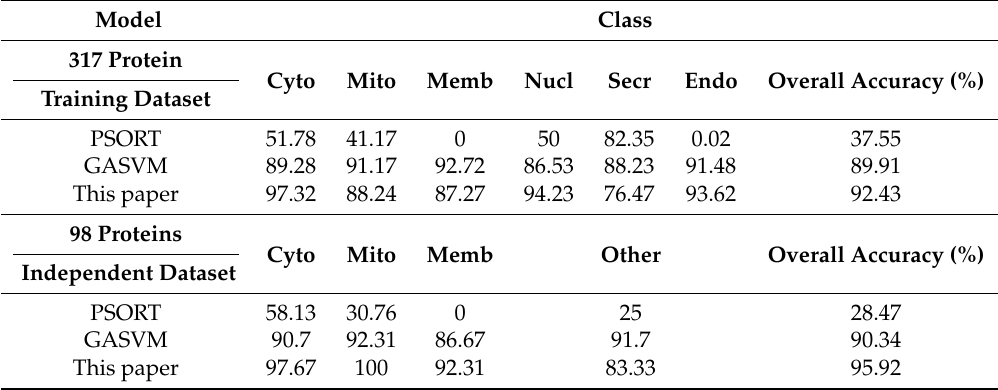
Table 15. Prediction results with different models on the 317 apoptosis proteins dataset and 98 independent proteins